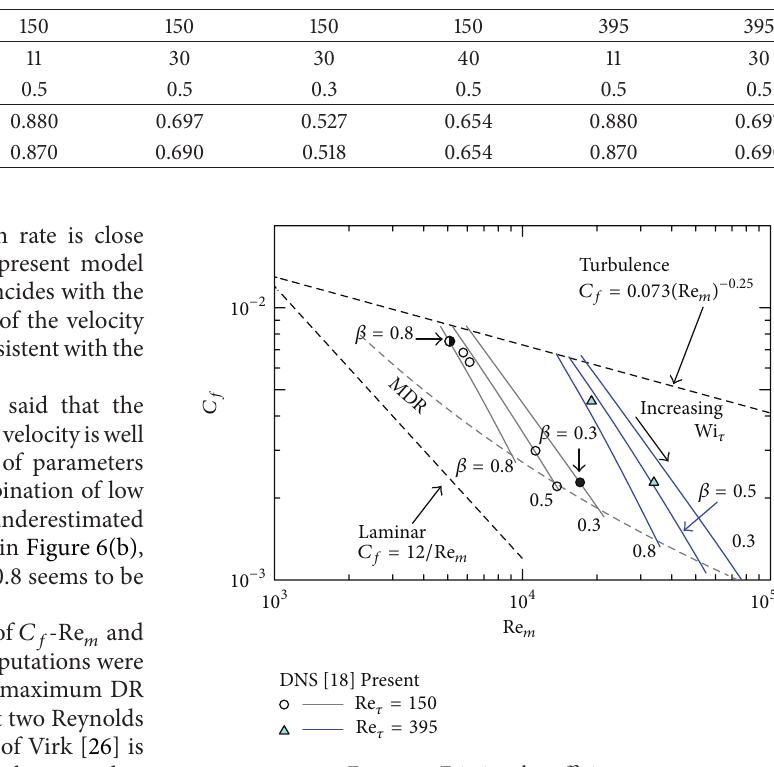
Figure 7: Frictional